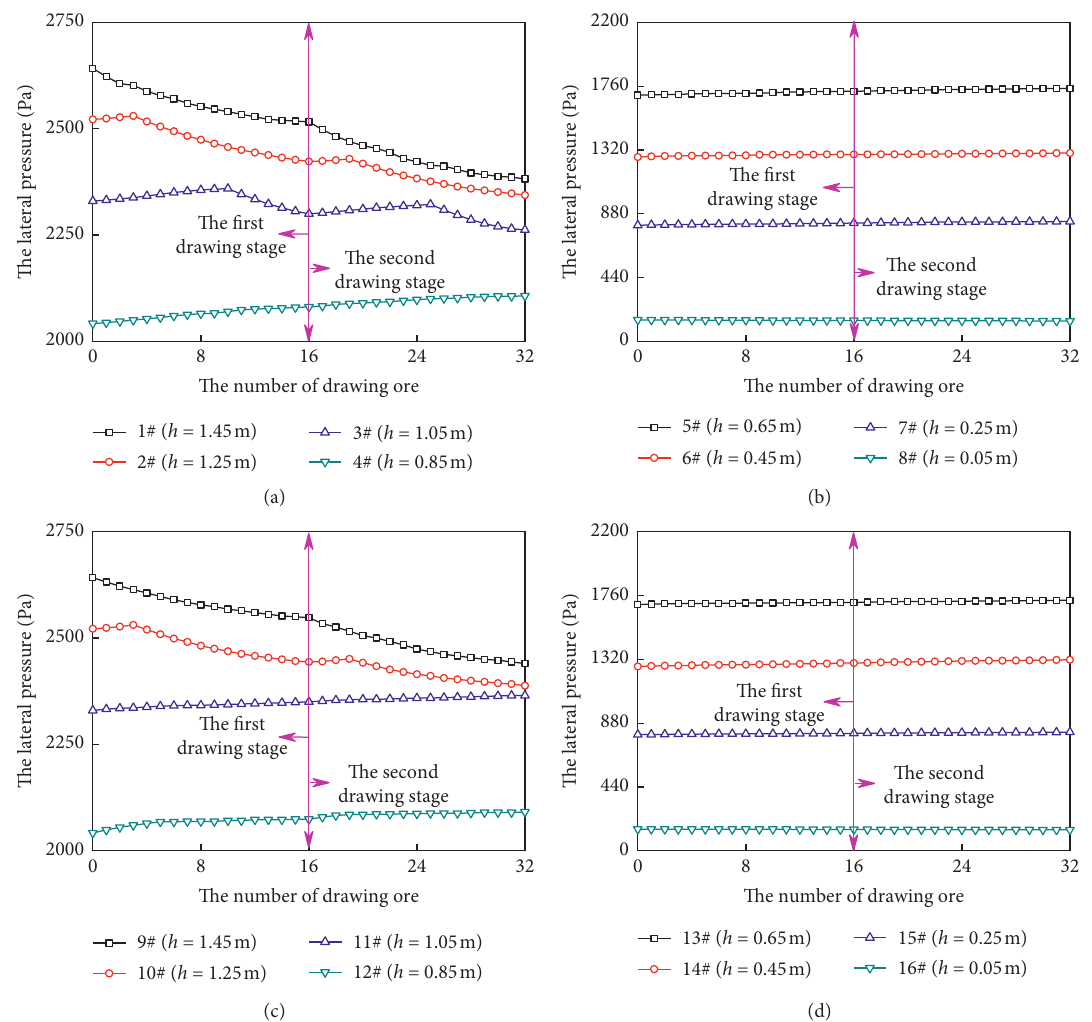
Figure 4: The relationship between the number of drawing ore and the values of lateral pressure with scheme